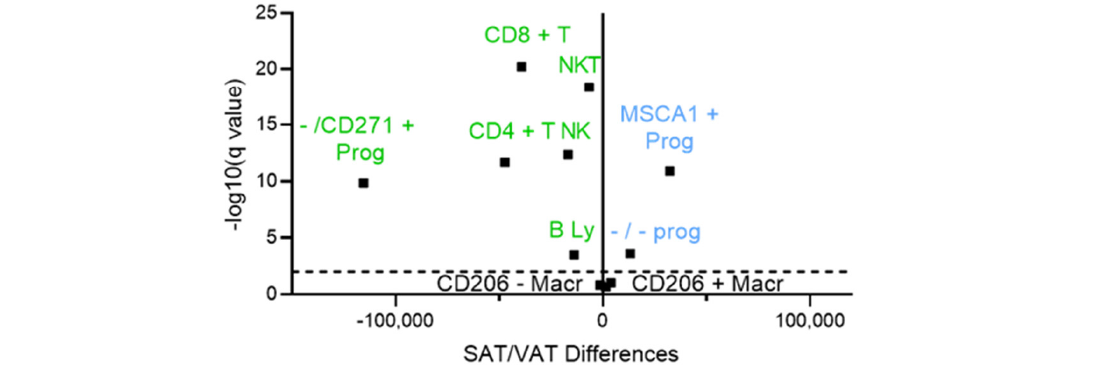
Figure 1. Differences in adipocyte size and stroma cell numbers between SAT and VAT. ( A ) Repre- sentative phase microscopy photography of VAT and SAT adipocytes are shown. Volcano plot of the differences in adipocyte diameter repartition (%) between SAT (blue) and VAT (green) according to − log10 (q value) for n = 101 paired tissues is shown. Numbers correspond to adipocyte diameter in µ m. ( B ) Representative dot plots of the flow cytometry analyses are shown starting from viable cells gated on side scatter (SSC)/forward scatter (FSC) of the stroma vascular cells (not shown). Progen- itor cells, defined as CD45 − /CD34 + /CD31 − , are gated from CD45/CD34 dot plot followed by CD31/CD34 dot plots (not shown). CD271/MSCA1 dot plot allows to further define the MSCA1 +, MSCA1 − /CD271 + ( − /CD271 +) and MSCA1 − /CD271 − ( − / − ) progenitor subsets. Macrophages defined as CD45 + /CD14 +, are gated from SSC/CD45 +. Macrophage subsets are further defined based on CD206 expression. T lymphocytes defined as CD45 + /CD19 − /CD3 + are gated from CD45 + /low SCC, B lymphocytes identified as CD3 − /CD19 +. T lymphocytes are further divided into CD4 + helper T lymphocytes and CD8+ cytotoxic T lymphocytes. NK (CD3 − /CD56 +) and NKT (CD3 + /CD56 +) are gated from SSC/CD45 + cells. Volcano plot of the differences in stroma– vascular cell numbers in SAT (blue) and VAT (green) according to − log10 (q value) for n = 135 to 140 paired tissues is